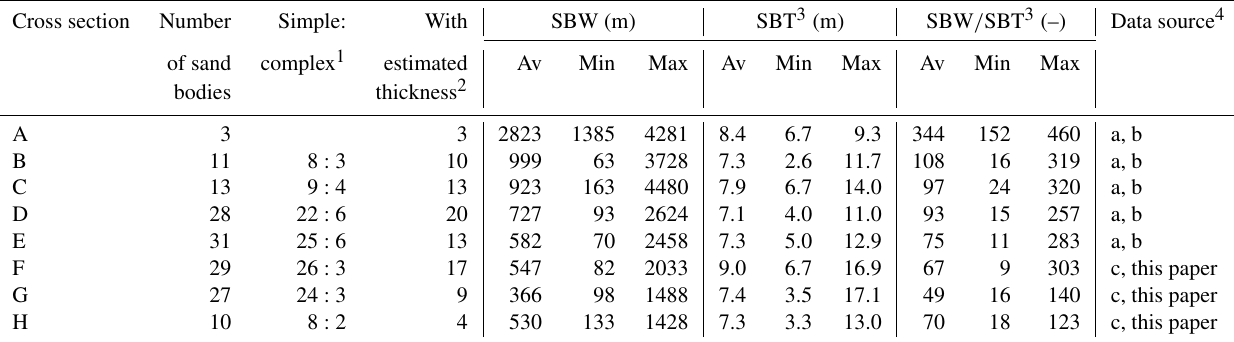
Table 2. Dimensions of the channel-belt sand bodies in the cross sections. Average (av), minimum (min) and maximum (max) values for the channel-belt sand body dimensions are given for each section. Cross section